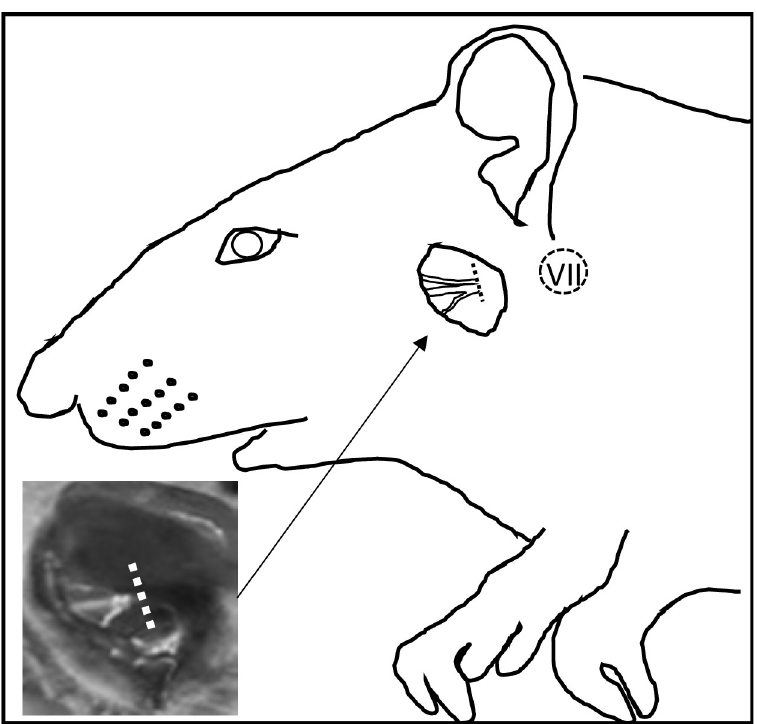
Fig 1. Drawing based on a photograph of an operated rat. The inset photograph shows only the operated portion. The left facial nerve at the level of the stylomastoid foramen was transected. The right side was untreated. The dotted circle indicates the estimated portion of the facial